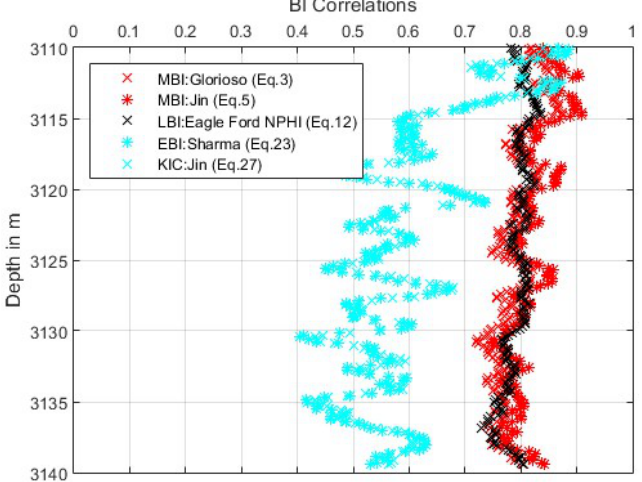
Figure 7. BI correlations from the Niobrara Formation applied over depth. Black colors show LBI correlations, red colors show MBI correlations, and blue colors indicate EBI correlations. The EBI is overall significantly lower than LBI and MBI correlations.